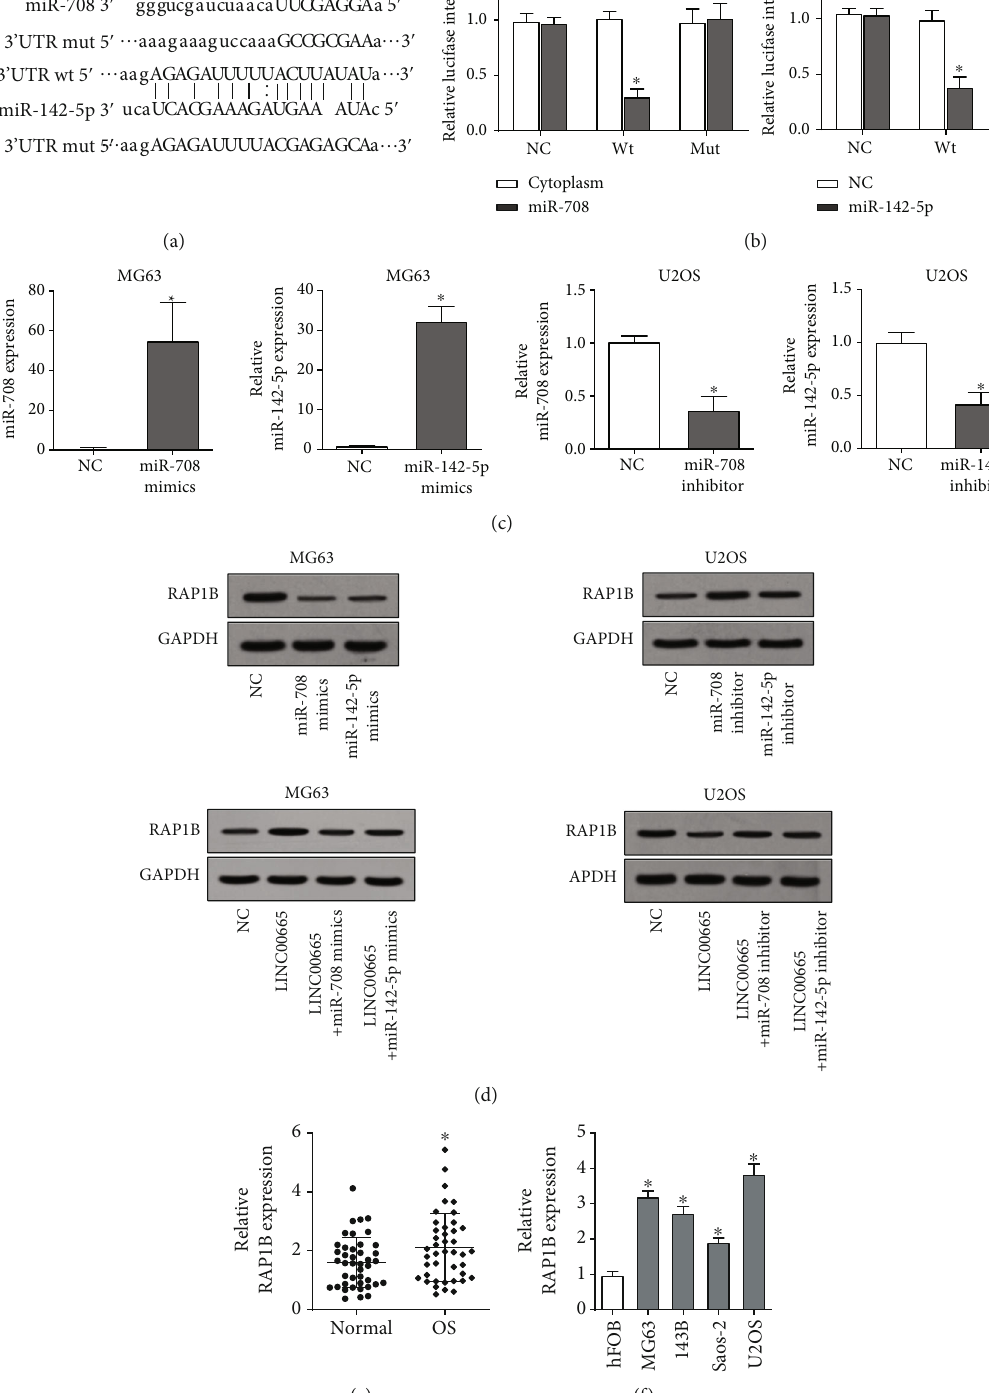
Figure 4: LINC00665 upregulates the RAP1B expression via miR-708 and miR-142-5p. (a) Predicted binding sequences of miR-708 or miR- 142-5p with 3 ′ UTR of RAP1B mRNA. (b) Predicted binding sequences of miR-708 or miR-142-5p with 3 ′ UTR of RAP1B mRNA were validated by luciferase reporter assays. (c) The e ffi ciency of the overexpression and knockdown of miR-708 and miR-142-5p in OS cells detected by qRT-PCR. (d) Western blot assays indicated the impact of miR-708 and miR-142-5p on the protein level of RAP1B, as well as the impact of LINC00665 together with miR-708 or miR-142-5p on the protein level of RAP1B. (e) Expressions of RAP1B mRNA in paired OS and nontumorous normal tissues were detected by qRT-PCR. (f) Expressions of RAP1B mRNA in OS cell lines and normal osteoblast cell line were detected by